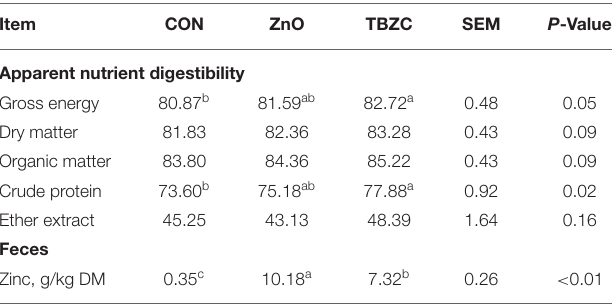
TABLE 5 | Effects of tetrabasic zinc chloride on fecal short-chain fatty acids concentrations (mg/g) in weaned piglets. Item CON ZnO TBZC